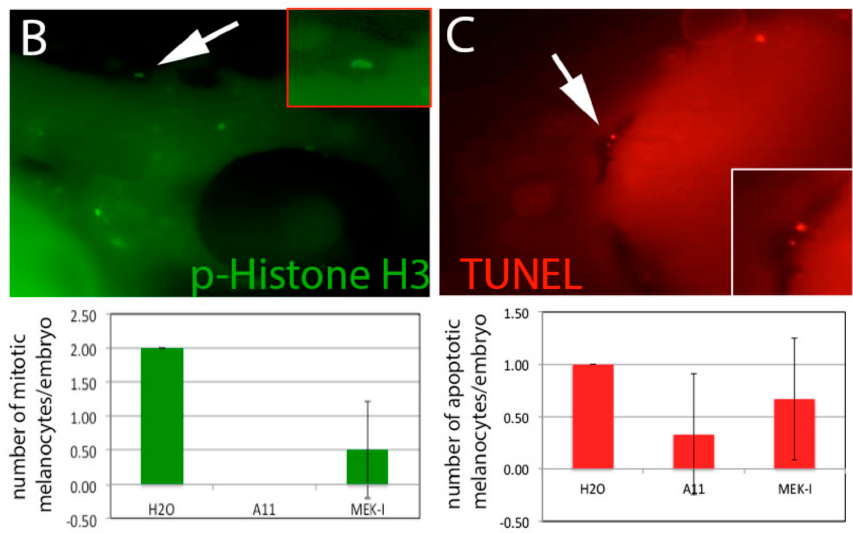
Figure 7. Inhibition of melanocyte differentiation and proliferation by A11. ( A ) In situ hybridization using dct gene riboprobe revealed fewer differentiated melanocytes in A11-PTU-treated embryos than those in PTU alone. The quantitative data is shown in the chart below. MEK-I has no effect on melanocyte differentiation; ( B ) Immunostaining using rabbit mAb for phosphorylated histone H3 (p-Histone H3) on embryos treated with A11 or MEK-I showed fewer mitotic cells. Arrow points to a melanocyte that was positive with p-Histone H3 (enlarged view in the insert). ( C ) TUNEL